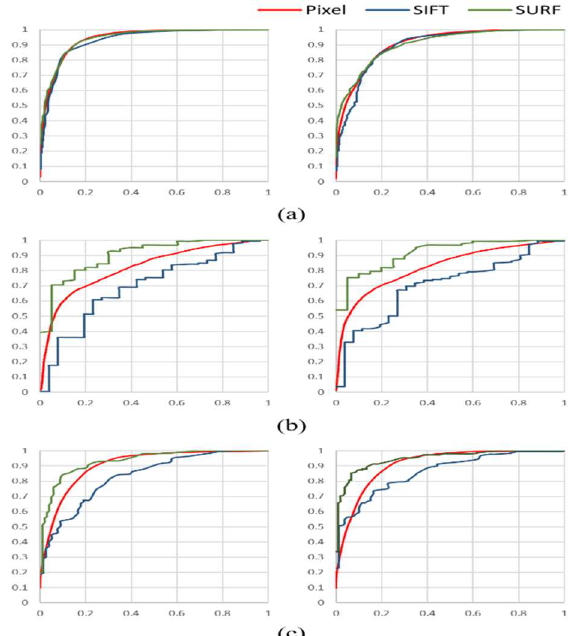
Figure 6. Comparison ROC of pixel-based and feature-based change detection methods, Left: MAD, Right: IR-MAD (((a)